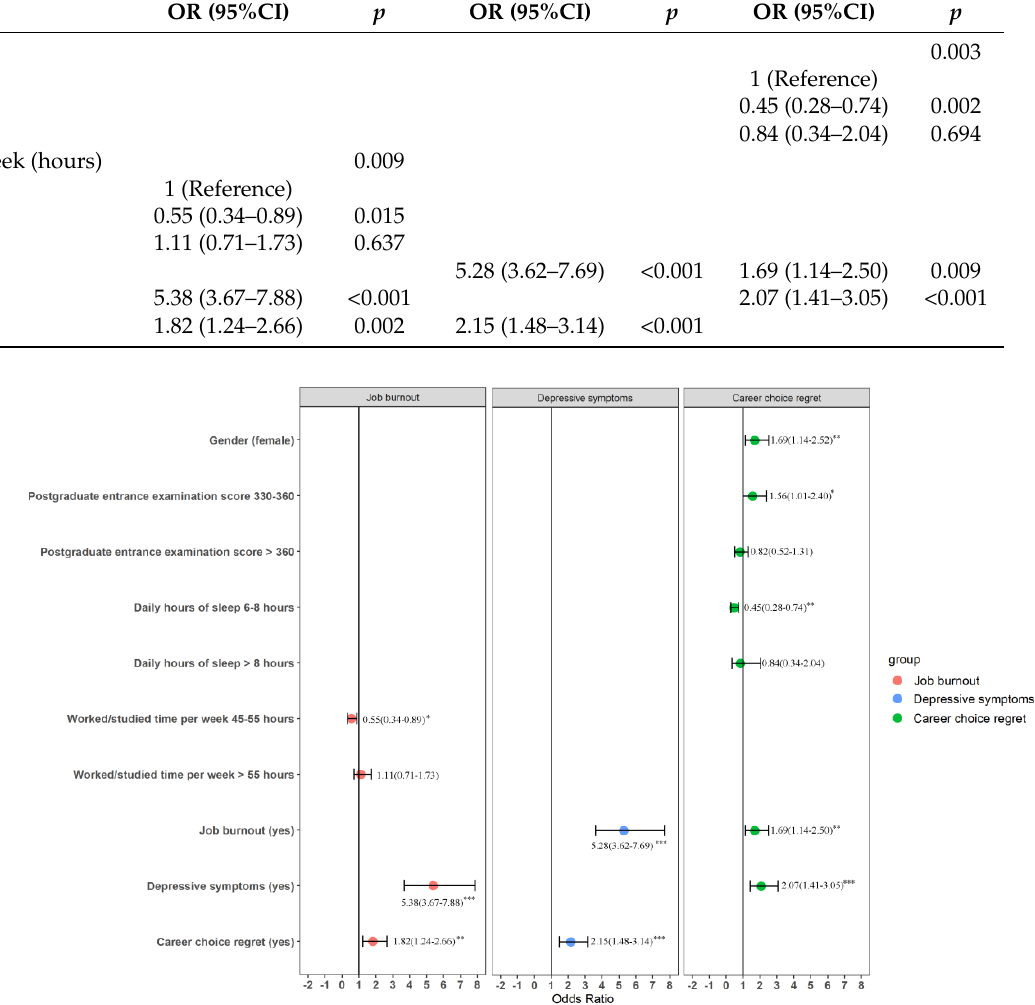
Figure 2. Risk factors of burnout, career choice regret, and depressive symptoms in dental postgraduates. * p < 0.05, ** p < 0.01, *** p <